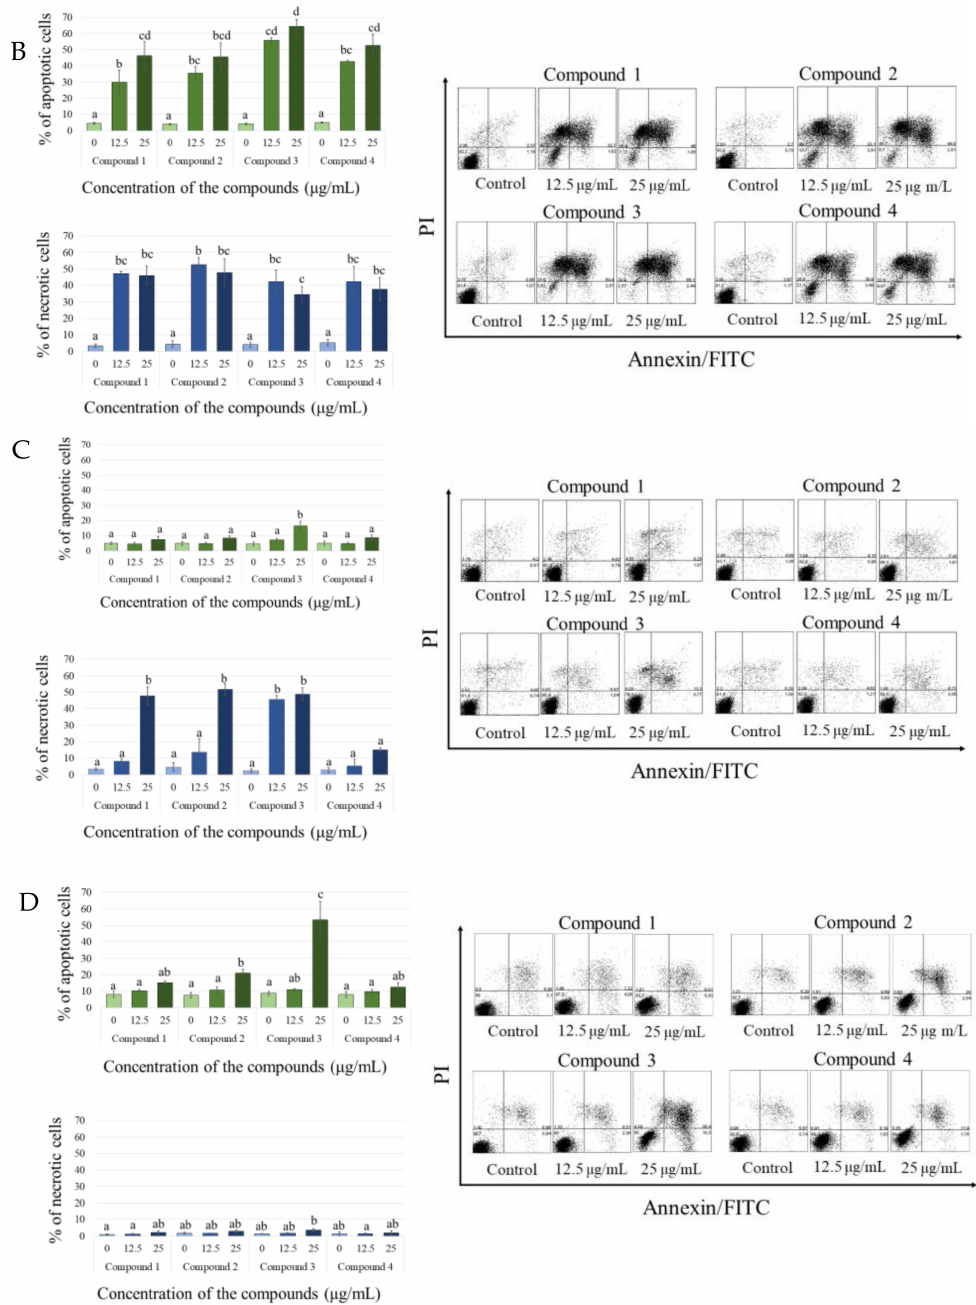
Figure 3. Percentage of apoptotic and necrotic cells in CLBL-1 ( A ), CLB70 ( B ), CNK89 ( C ) and GL-1 ( D ) after 48 h of incubation with the culture medium alone (0) or 12.5 and 25 µ g/mL of the tested flavanone-derived γ -oxa- ε -lactones. On the right: representative dot-plots of annexin V/PI staining. The values are means of three independent experiments. Statistical differences were analyzed using one-way ANOVA followed by Tukey’s multiple comparison test. Values without common letters (a, b, c) in the superscript differ statistically ( p <